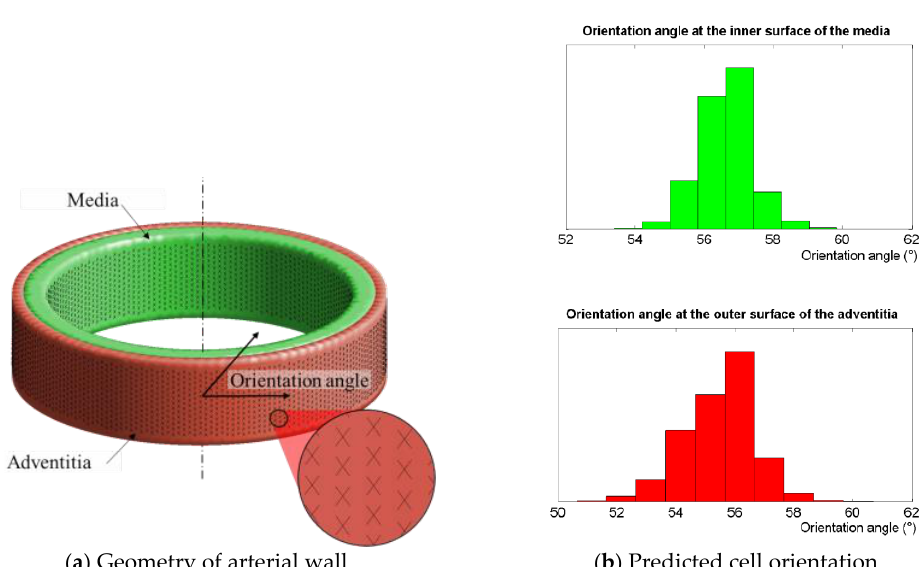
Figure 3. Computed cellular orientation in the physiological case of the inflation of an arterial segment. Orientation angles (defined as the angle between computed preferential orientation and the transverse plane of the arterial segment) were computed at the inner surface of the media and the outer surface of the adventitia. Values were respectively ±56.6° (±0.8°) at the inner surface of the media and ±55.5° (±1.2°) and the outer surface of the adventitia, to be compared with the values around 50° used when modelling the anisotropic structure of the collagenous structure of the artery [23].